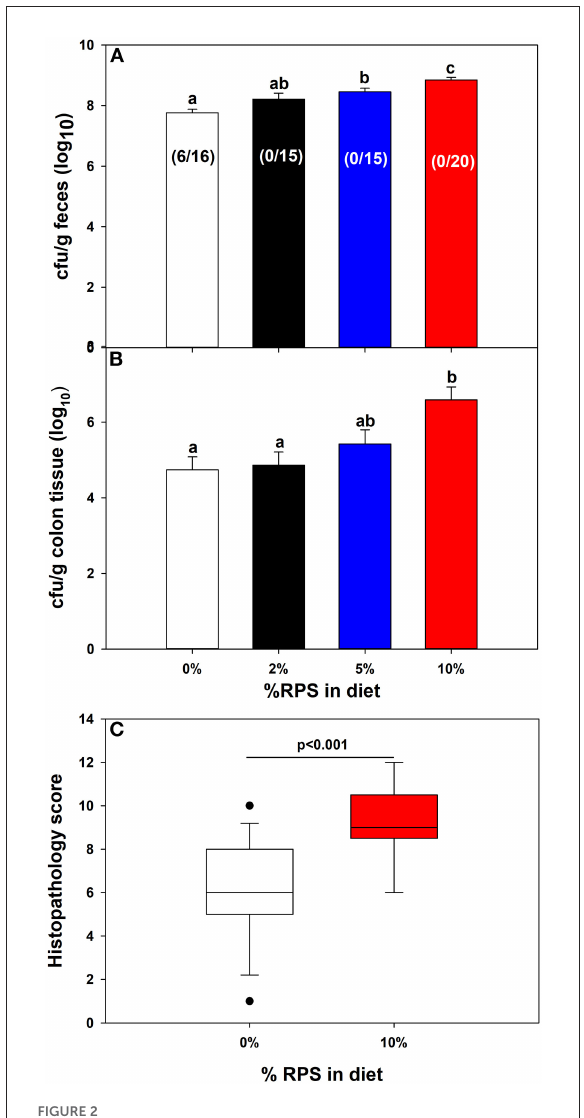
FIGURE2 Feeding RPS altered colonic colonization of Cr and histopathology. Mice were fed the TWD for 6 weeks followed by the RPS diets for 3 weeks and then infected with Cr . (A) Fecal samples were collected at 4 days post-infection and the Cr fecal burden determined. Results for productively infected mice are expressed as the mean ± SEM of log 10 transformed Cr colony forming (CFU)/g feces, Data from three independent experiments combined ( n = 16-20). Shown in parentheses are the # of unproductively infected mice over the total mice inoculated. (B) The amount of mucosa adherent Cr was determined on colon sections obtained 12 days post-infection. Results are the mean ± SEM of log 10 transformed Cr colony forming (CFU)/g colon tissue. Data is from four independent experiments combined using productively infected mice only n = 14–26/group. (C) Histopathology scores for infected mice fed the 0% RPS diet vs. the 10% RPS diet. Results of the Mann-Whitney Rank Sum Test are displayed as box plots. Data from three independent experiments were combined, n = 13–17 mice/group. Groups with different letters are significantly different, p <